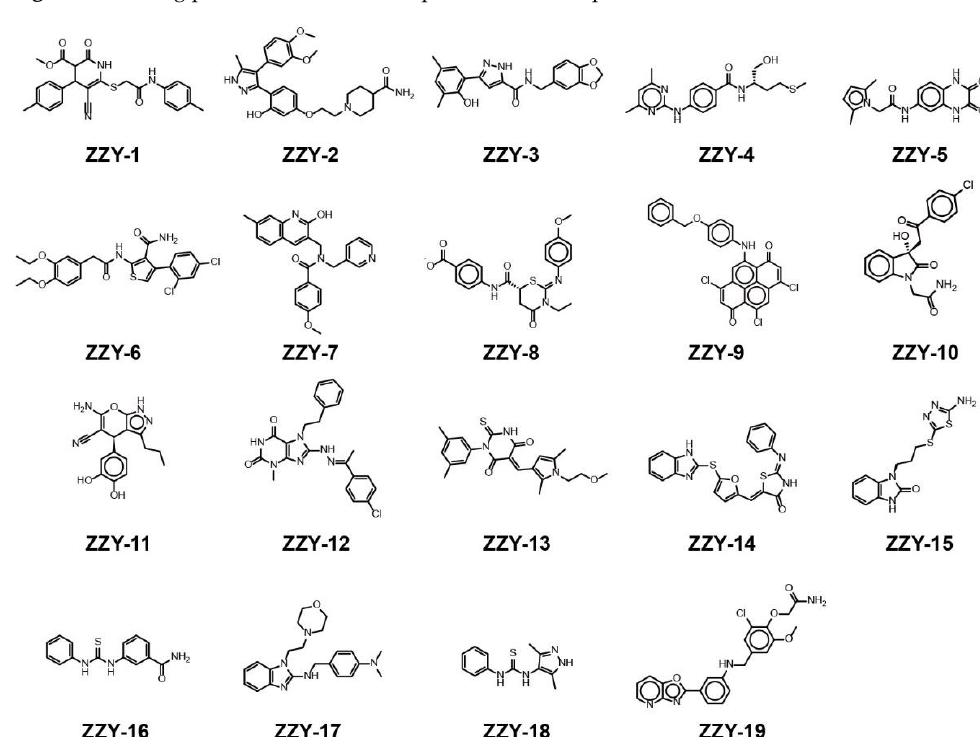
Figure 3. Binding pattern of selected compounds to ULK1 protein.